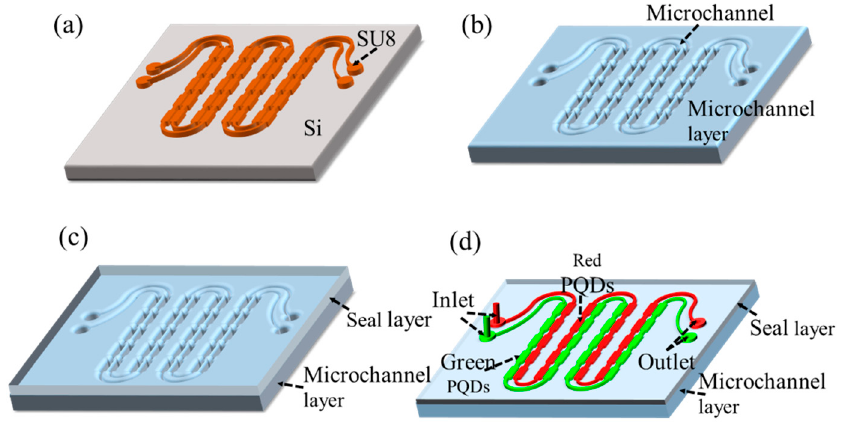
Figure 2. Schematic diagram of the production process of FQCL chip: ( a ) SU8 silicon mold, ( b ) flexible microchannel layer, ( c ) flexible PDMS chip, and ( d ) FQCL.